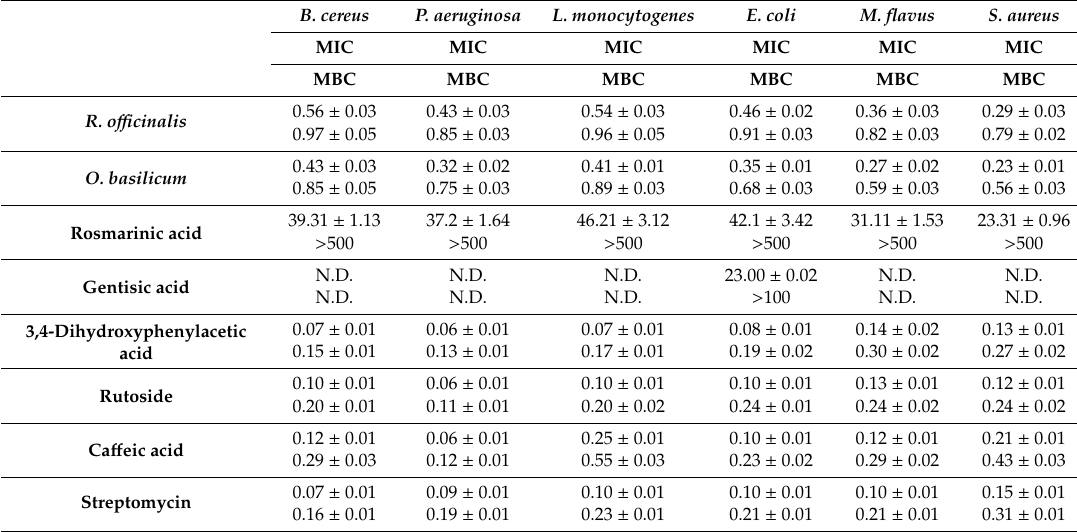
Table 4. R. o ffi cinalis and O. basilicum leaf extracts, rosmarinic acid, 3,4-dihydroxyphenylacetic acid, gentisic acid, and rutoside antibacterial activities by means of minimum inhibitory (MIC) and bactericidal concentration (MBC) in (mg mL − 1